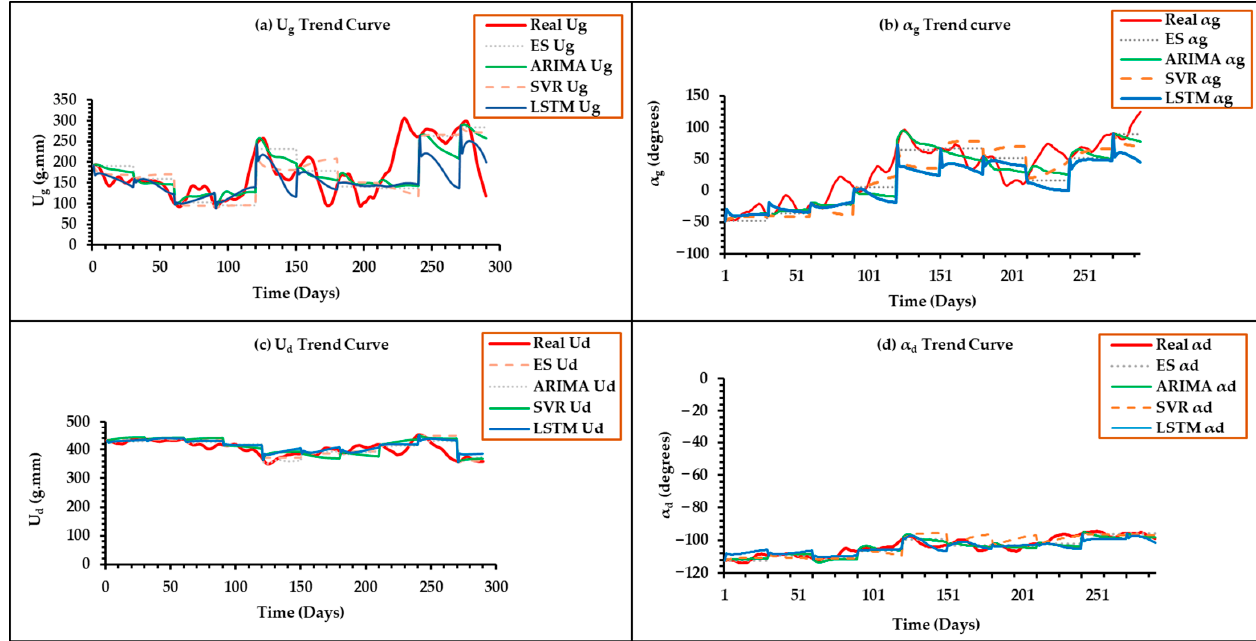
Figure 16. Comparison trends of ( a ) U g ( b ) α g ( c ) U d ( d ) α d.